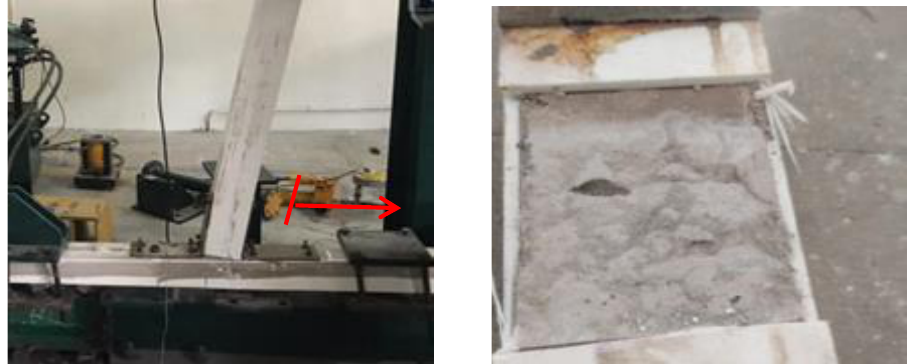
Figure 8. Failure pattern of beam-columns manufactured from GFRP infilled with and without HVFA-ECC.